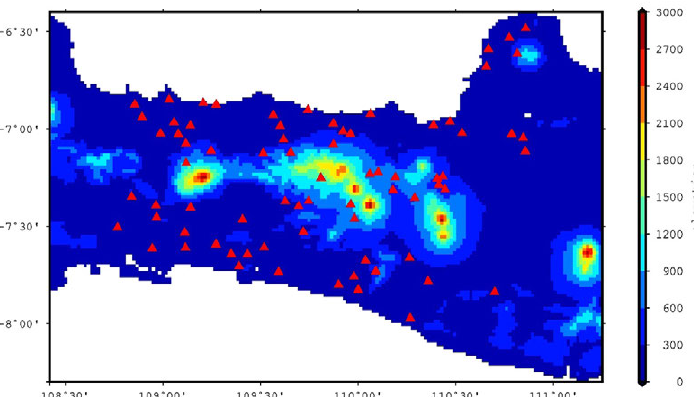
Fig. 3. Fig. 3. Rain gauge stations used for the analysis, represented as red triangle. Shading color represent elevation. (Precipitation data are from BMKG; elevation data are based on ETOPO).